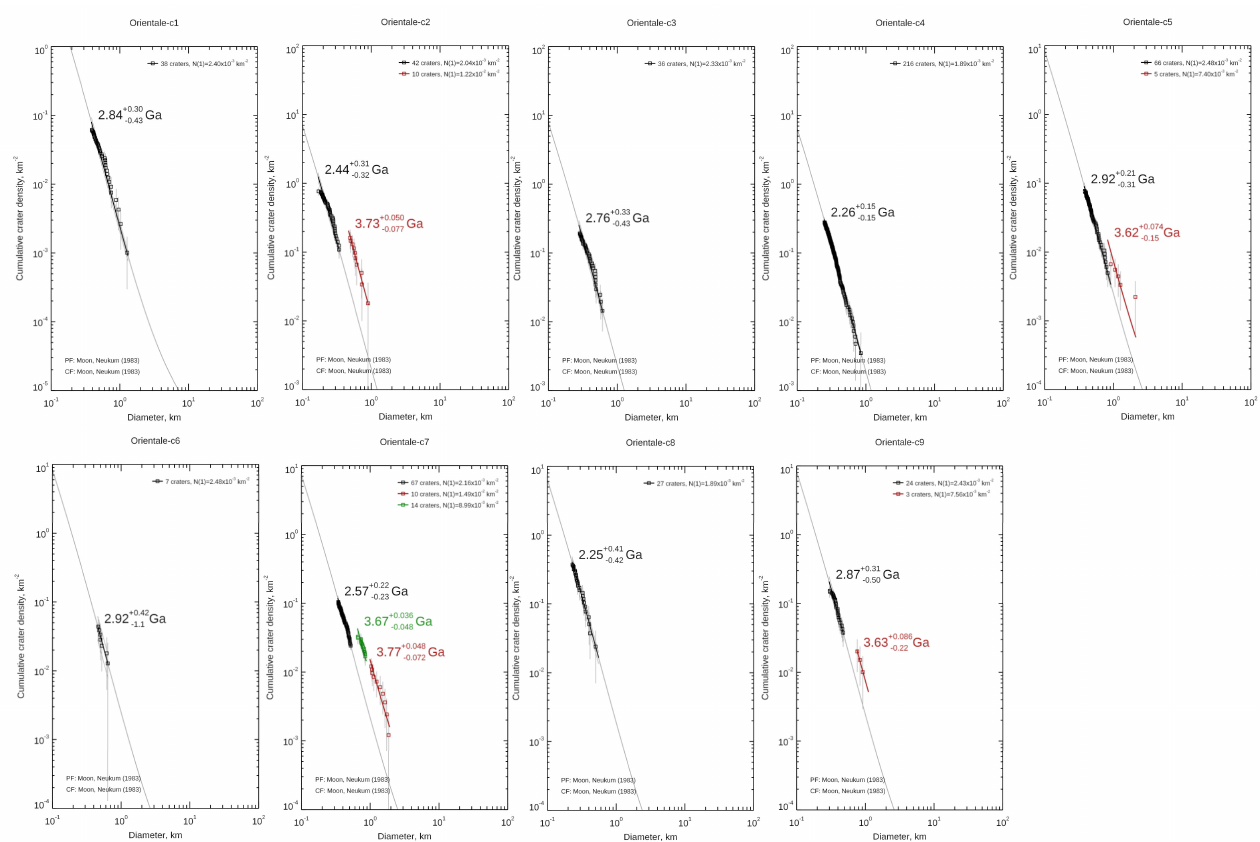
Figure 5. CSFD and mean AMAs of sub-units c1–c9 in Mare Orientale. Black characters denote the surface age of basalts, the red and green colors represent the older age of the underlying basalt. The AMAs were estimated with the Craterstats2 Tool with the production and chronology functions of